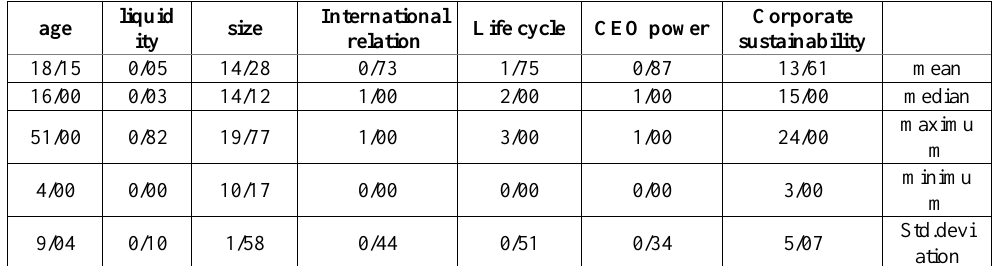
Table 3. Descriptive statistics of research